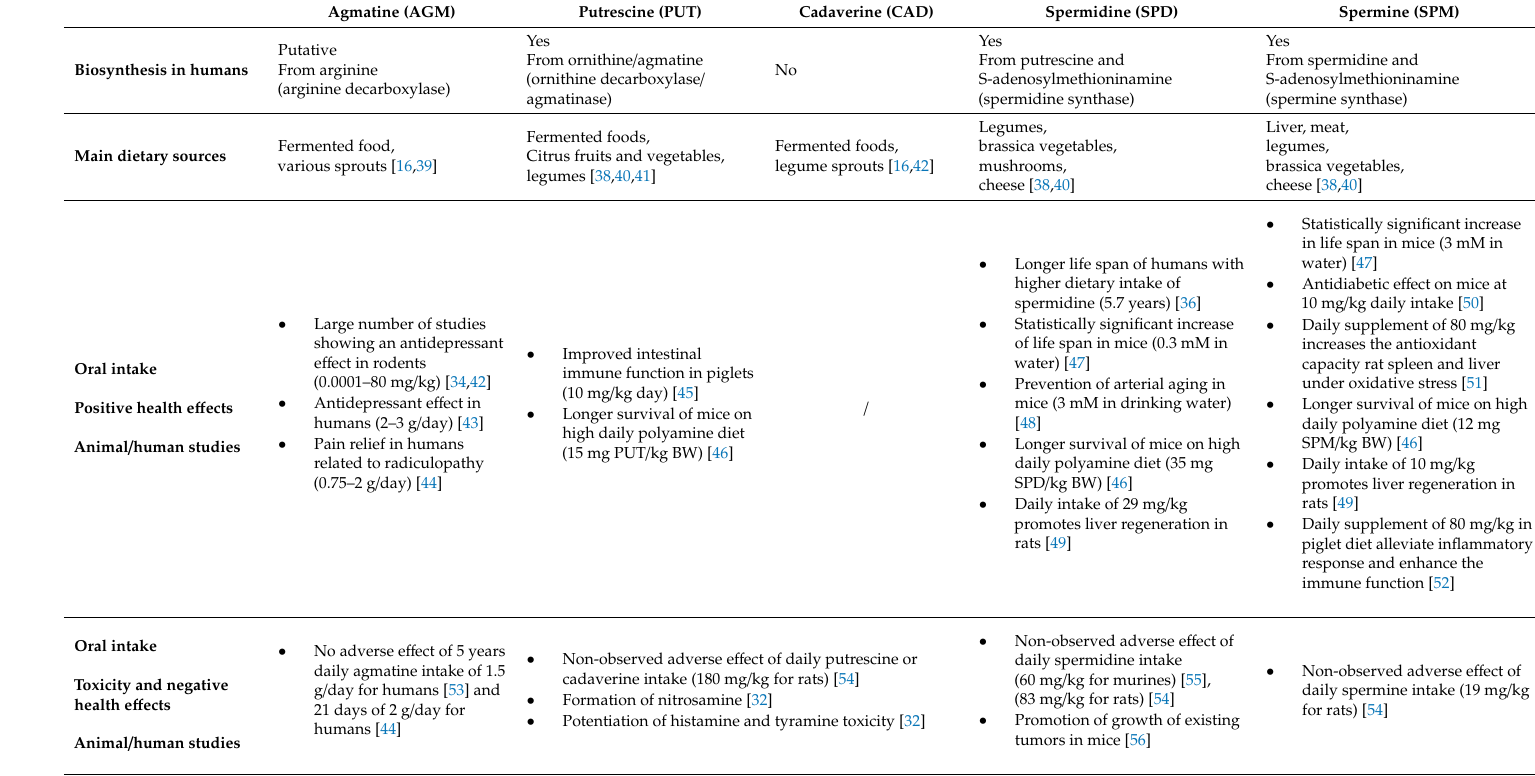
Table 1. Food sources and health e ff ects of dietary